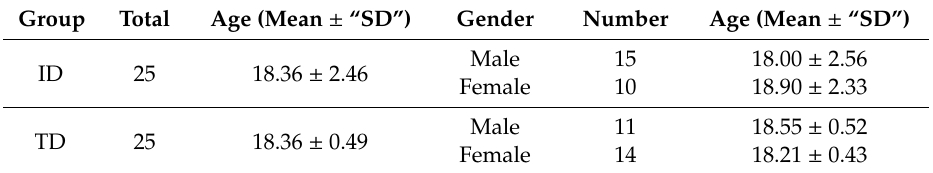
Table 2. Summary of the age, gender, and sample size for the ID and TD groups. Both groups had the same number of participants and an equal range of the